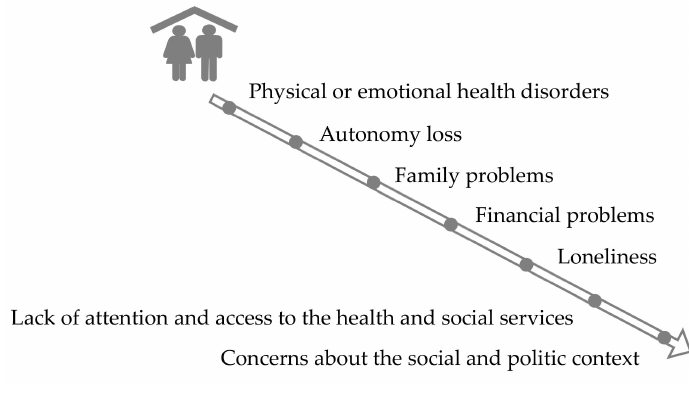
Figure 5. Barriers to HA in